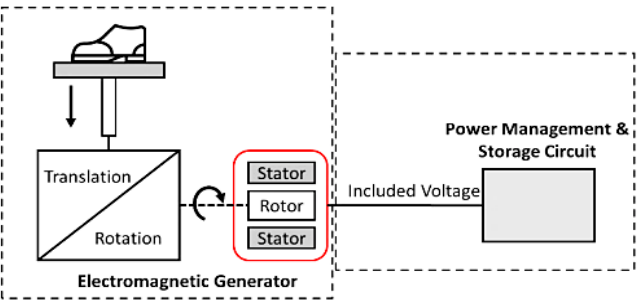
Figure 18. Block diagram of electromagnetic harvesting system [36].